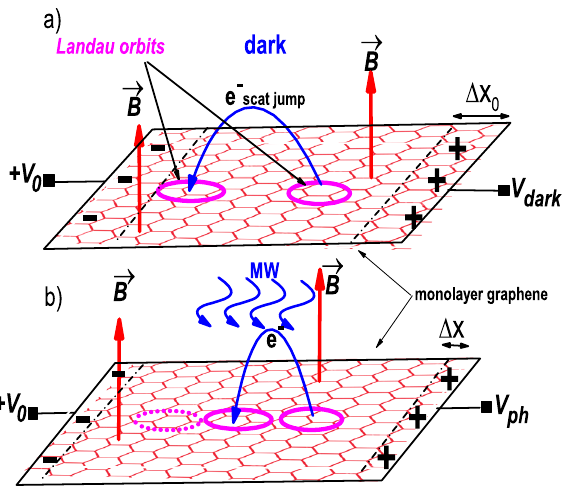
Figure 1. Schematic diagram showing the dynamics of dark and irradiated monolayer graphene (encapsulated) V 0 . ( a ) In the dark case the scattered electron mostly jump, between Landau orbits, under external voltage + in the direction of the positive voltage. As a result two lines of opposite charges build up at facing sides of the sample. ( b ) With radiation, the scattering jump distance changes harmonically with B giving rise to radiation- induced photovoltage